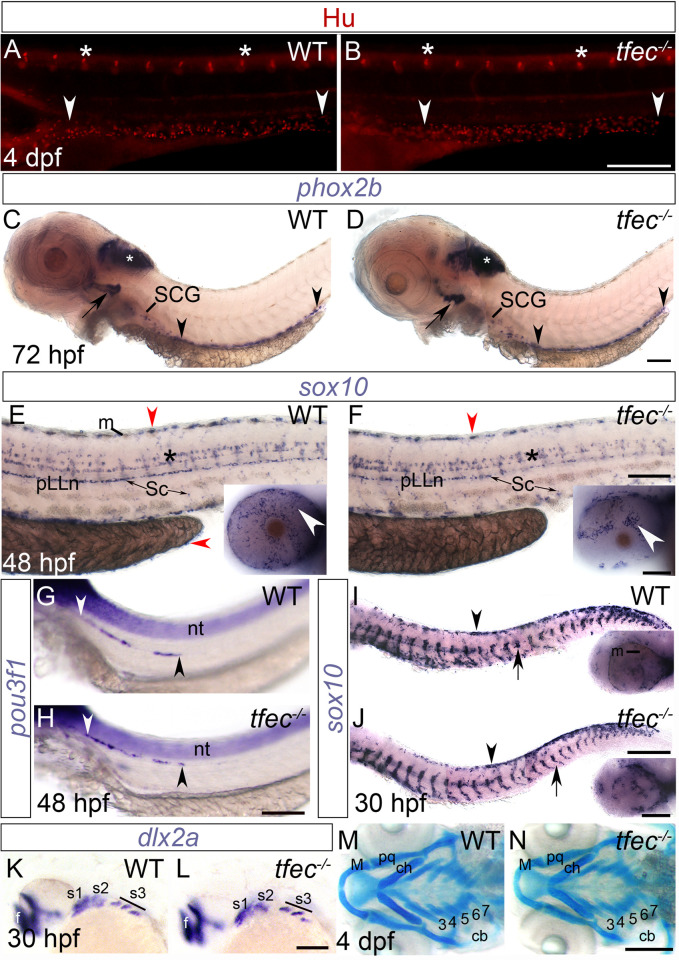
Development of skeletal and neural NC derivatives is unaffected in tfec mutants.(A-J) Peripheral nervous system derivatives develop normally in tfec mutants. (A,B) At 4 dpf, the DRG (asterisks) and enteric neurons (arrowheads) number and positioning, as revealed by immunofluorescent detection of Elav1/Hu, is indistinguishable between tfec mutant embryos (B) and WT siblings (A). (C,D) phox2b expression, detected by whole-mount in situ hybridisation, at 72 hpf. The formation and the extent of migration of enteric nervous system progenitors (region between arrowheads) are indistinguishable between tfec mutants and WT siblings. Likewise, expression in the earliest differentiating region of the sympathetic ganglia chain, the superior cervical ganglion (SCG), is unaffected. phox2b expression is also indistinguishable in the hindbrain (white asterisks) and in placode-derived neuronal progenitors in the cranial ganglia associated with the branchial arches (arrows). (E,F) At 48 hpf, sox10 expression analysis showed indistinguishable numbers and distribution of Schwann cells (Sc) occupying the pLLn and spinal nerves. Likewise, oligodendrocyte progenitors throughout the CNS appear normal in their specification, numbers and migration (asterisks). sox10 expression is detectable in iridophore positions (red arrowheads) and in eye iridophores (insets, white arrows), that are strongly affected in homozygous tfec mutants. (G,H) pou3f1 expression analyses at 48 hpf show that glial progenitors on the posterior lateral line nerve (pLLn; area between arrowheads) develop normally in tfec mutants. (I,J) sox10 staining at 30 hpf indicates no observable alterations in the migration of specified neural progenitors through the medial pathway (arrows) in tfec mutants, compared to WT siblings. Likewise, the number and distribution of sox10-positive premigratory NC progenitors (arrowheads) is unaffected. tfec mutants were identified by lack of RPE melanisation (I,J, insets). (K,L) At 30 hpf, dlx2a expression shows that formation of the three streams (s1-s3) of migrating cranial NCCs is unaffected in tfec mutants. Staining is also indistinguishable in the forebrain (f). (M,N) The cranial cartilage at 4 dpf is unaffected in tfec mutants, versus WT siblings, as indicated by Alcian blue staining. Numbered 3–7 are the positions of the branchial arches. (B,H,L,N): tfecvc60 allele, (D,F,J): tfecba6 allele. cb, ceratobranchials; ch, ceratohyal; M, Meckel’s cartilage; nt, neural tube; pq, palatoquadrate. (A-L): lateral views. (M,N): dorsal views. Head towards the left. Scale bars: (A, B, G, H, K-N): 200 μm; (C-F, I, J): 100 μm.